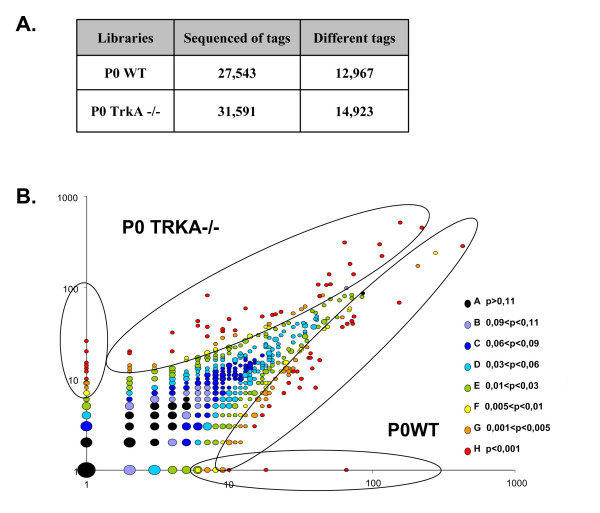
(A) Numbers of sequenced tags and different tags for each library. (B) Scatter plot showing a comparative expression level of tags between P0 WT and TrkA mutant. The occurrence of each tag was plotted on a logarithmic scale (tags with no expression in one library were set to a value of one). A color is attributed to the tag according to the significance of the P value. Differently expressed tags (P < 0.01) are encircled.